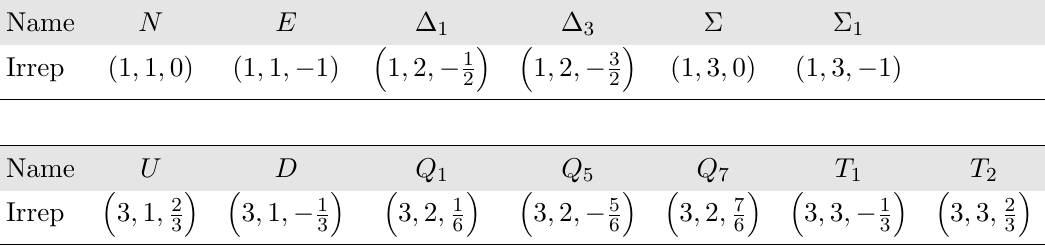
Table 3. Fermion exits: new vector-like fermions that can couple linearly to standard model particles. Symbols are taken from [18].